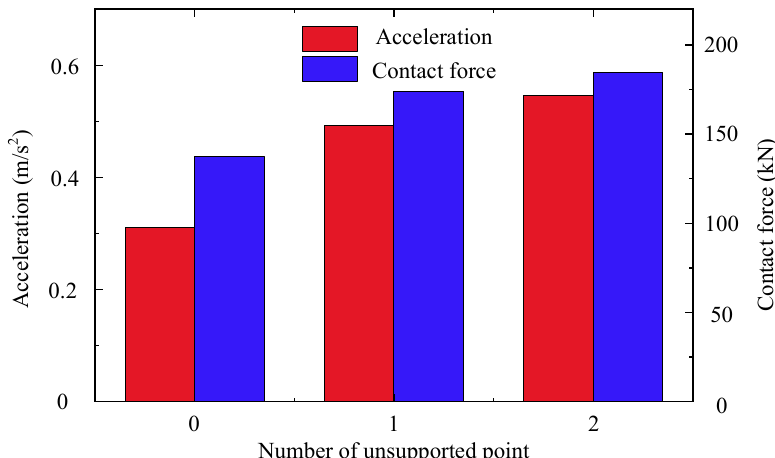
Figure 8. The effect of the bilateral unsupported track at point B.